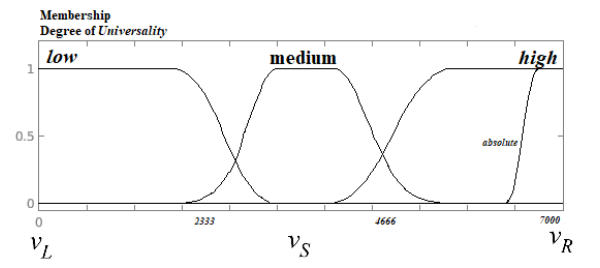
Figure 1. Linguistic Universality as a Evaluative